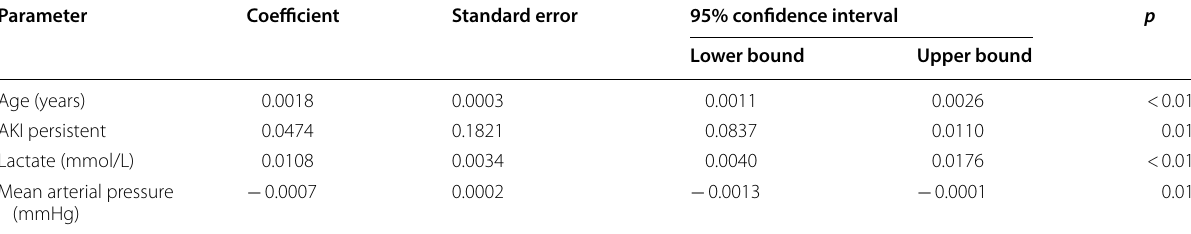
Table 3 Variables associated with renal RI affording linear mixed model